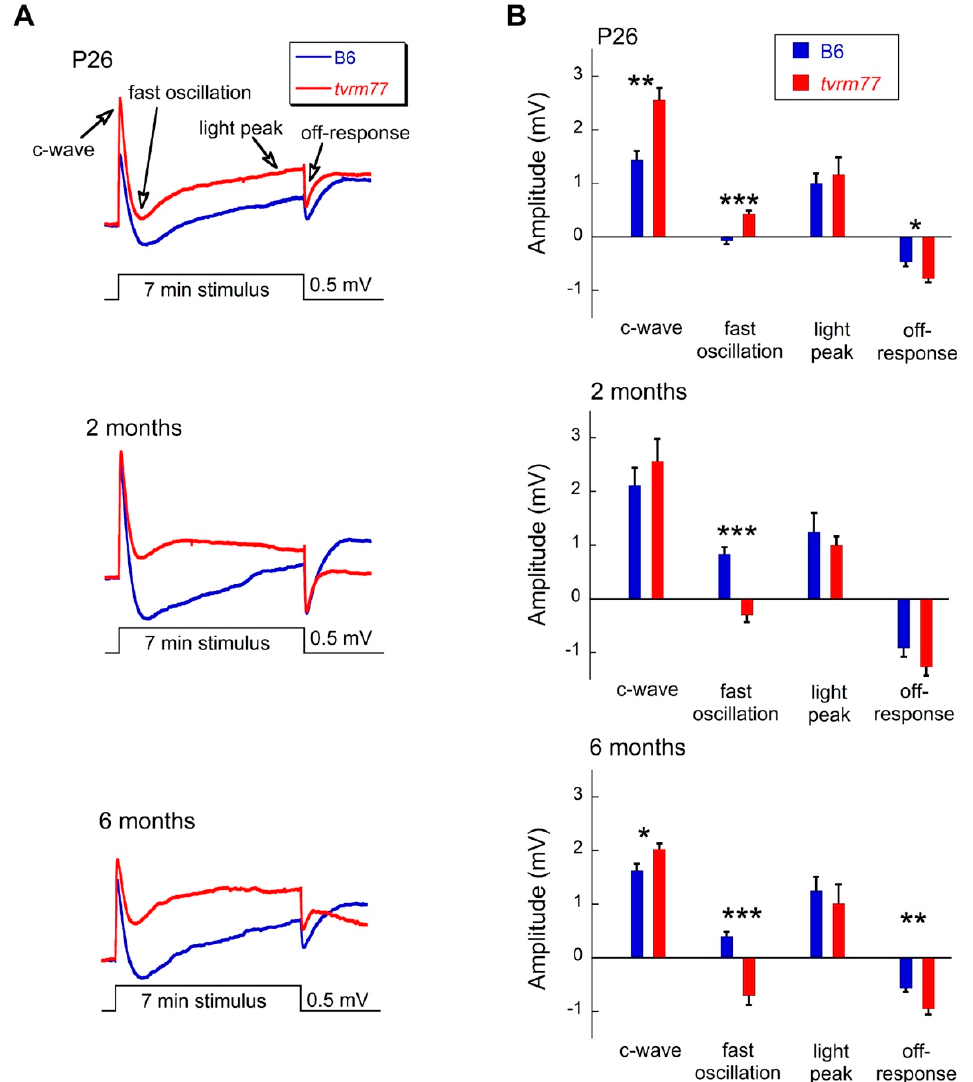
Figure 8. Analysis of the response properties of the RPE. ( A ) dc-ERG waveforms obtained in response to 7 min duration stimuli of 2.4 log cd m − 2 from B6 and tvrm77 mice at 26 days (P26), 2 months, or 6 months of age. Responses of tvrm77 mice have a consistent change where the fast oscillation component remains above the pre-stimulus baseline. Waveforms indicate the average response of 4–10 mice. ( B ) Amplitude of the major response components of the dc-ERG. Bars indicate the mean (±SEM) response of 4–10 mice and asterisks indicate statistical significance: * p < 0.05 **; p < 0.01; *** p < 0.001.